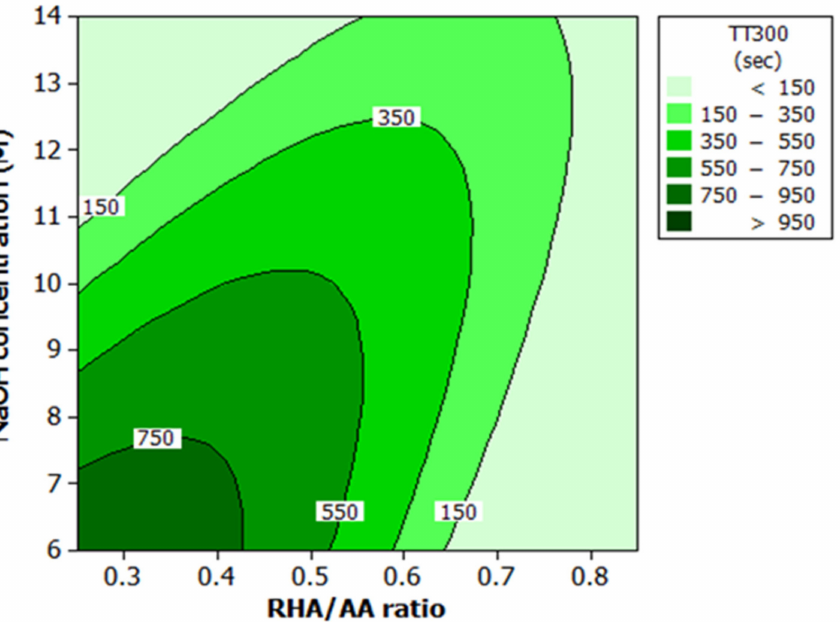
Figure 6. Contour plot for the effect of RHA/AA ratio and NaOH concentration on the TT300 in fire-retardant